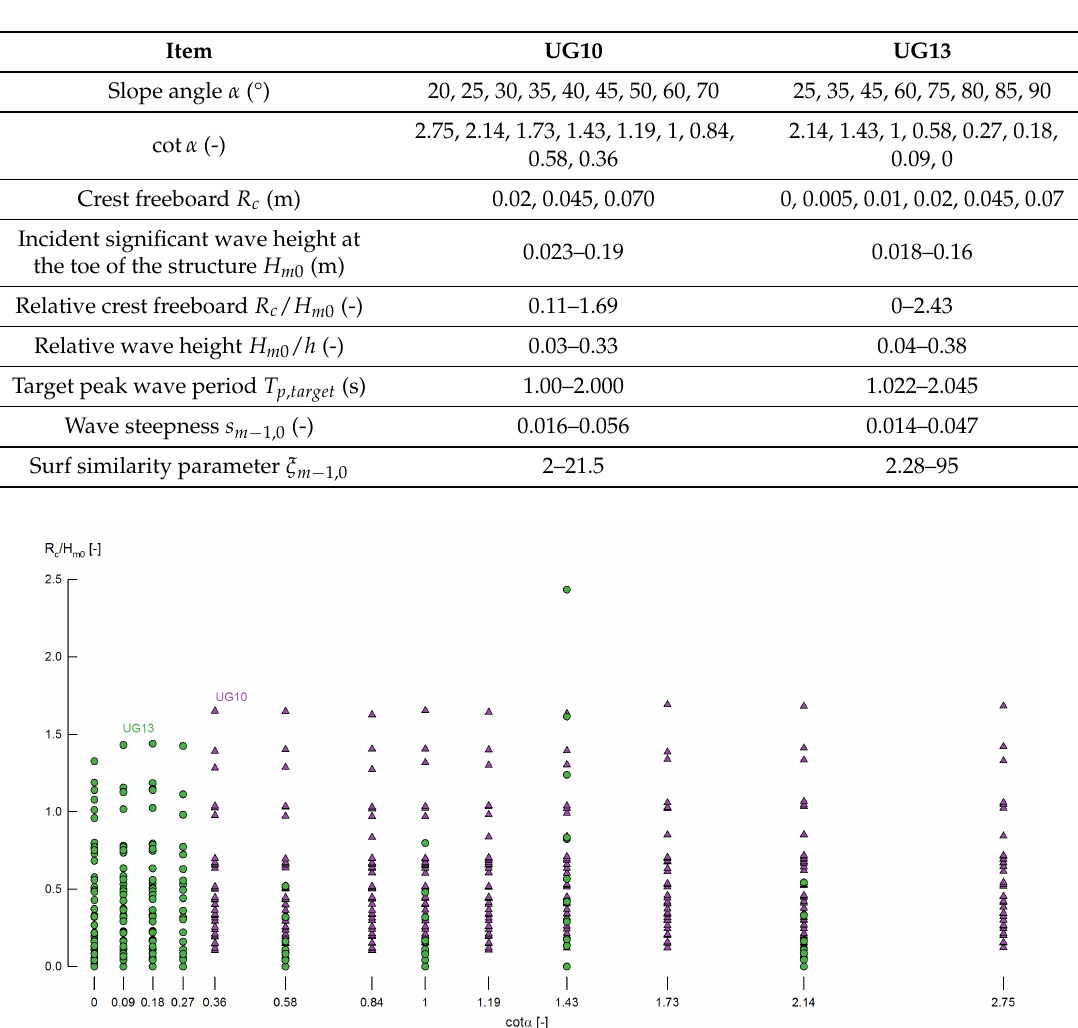
Table 5. Overview of UG10 and UG13 dataset.